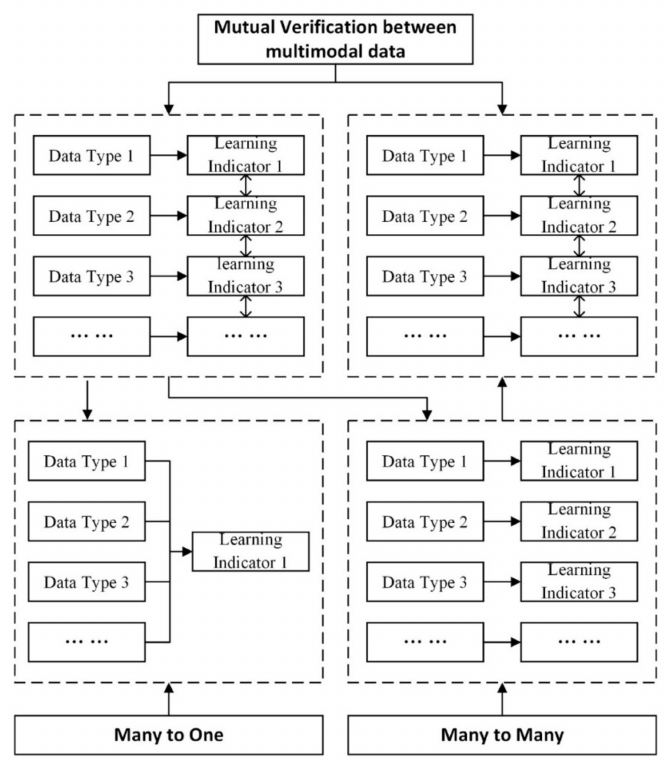
Figure 4. Data integration